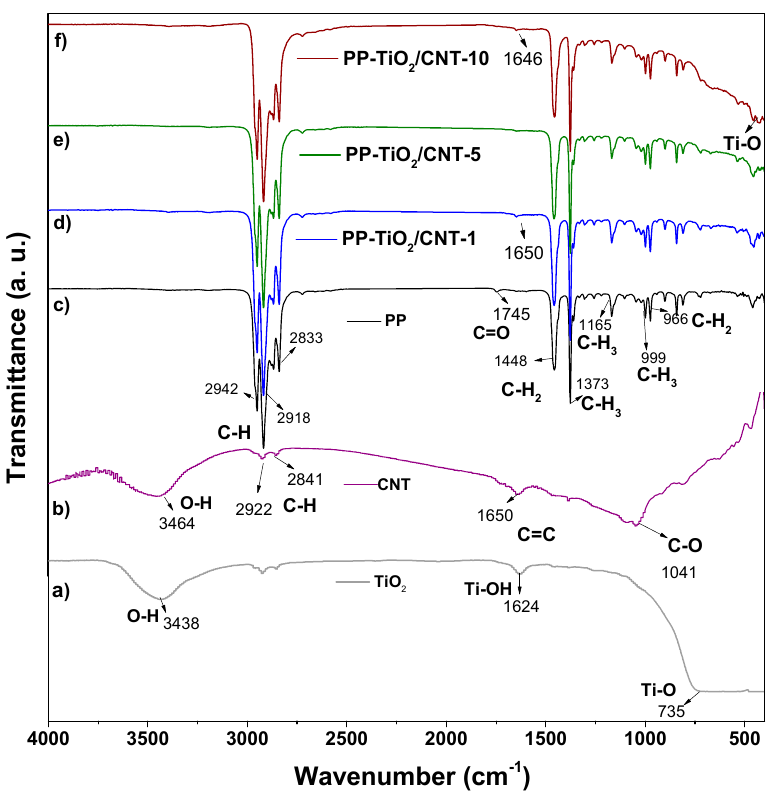
Figure 3. FT-IR spectra of nanocomposite PP-TiO 2 / CNT (1, 5 and 10%), polypropylene (PP), carbon nanotubes (CNT) and TiO 2 .